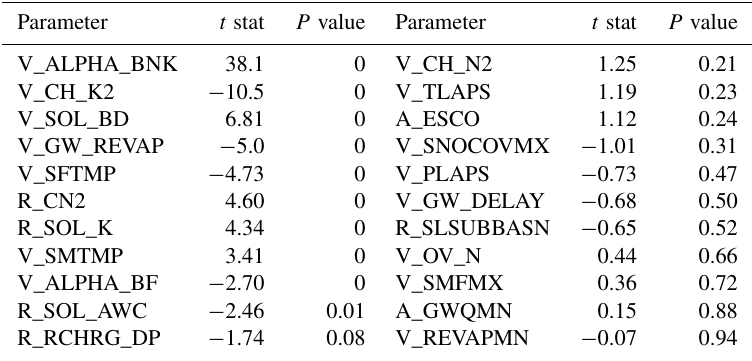
Table 3. Basin-wide sensitivity ranking calculated from 22 selected parameters using SUFI-2. Parameter t stat P value Parameter t stat